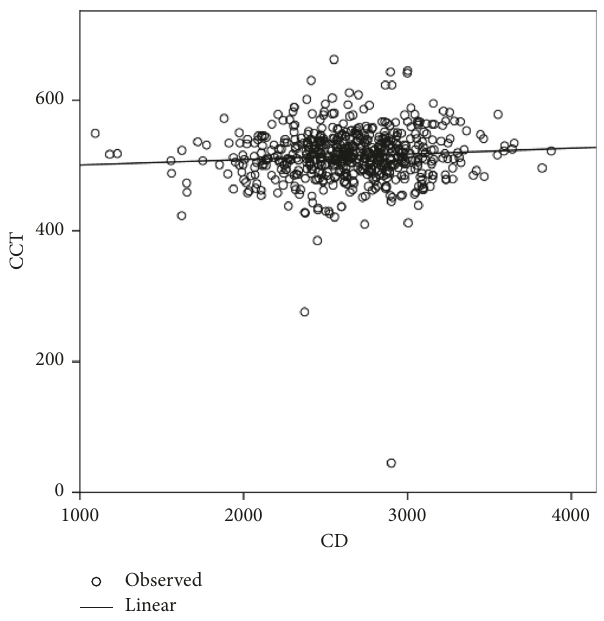
Figure 5: Relationship between the central corneal thickness (CCT) and the mean corneal endothelial cell density (MCD) in Egyptian subjects with healthy Table 5: Corneal endothelial cell loss in different age groups of Egyptian subjects with healthy eyes.